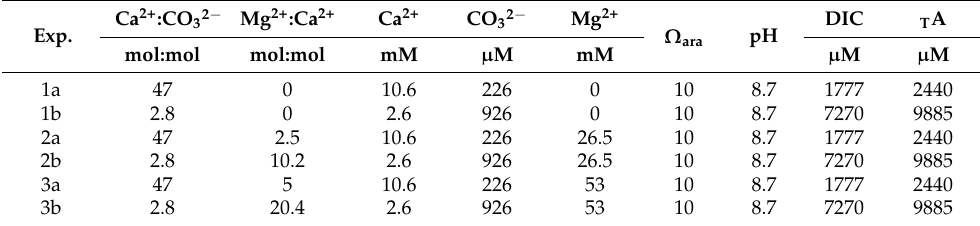
Table 1. Solutions setup for incubation experiments. Calcium, magnesium, and DIC concentrations are arranged by the amounts of CaCl 2 , MgCl 2 , and NaHCO 3 added to the solutions. Temperature and salinity remained constant at 25 ◦ C and 36 g kg − 1 , respectively. Carbonate concentrations and T A are calculated for equilibrium carbonate chemistry in NaCl using the dissociation constants of [41].